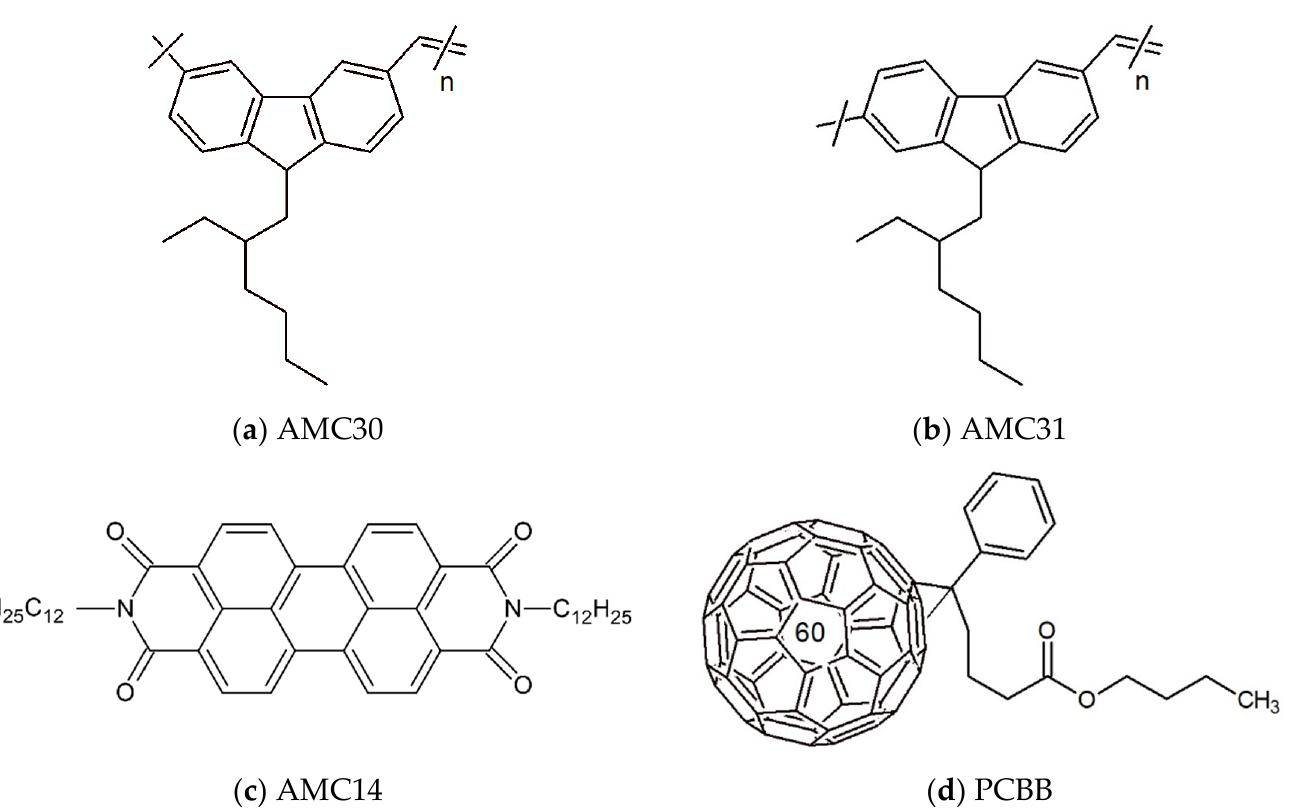
Figure 1. Molecular structure of poly(N-(2-ethylhexyl)-3,6-carbazolylene-vinylene)/AMC30 ( a ); Figure poly(N-(2-ethylhexyl)-2,7-carbazolylene-vinylene)/AMC31 ( b ); N,N′-bis-(1-dodecyl)perylene- 3,4,9,10 tetracarboxylic diimide/AMC14 ( c ); [6,6]-phenyl C 61 butyric acid butyl ester/PCBB ( d ).